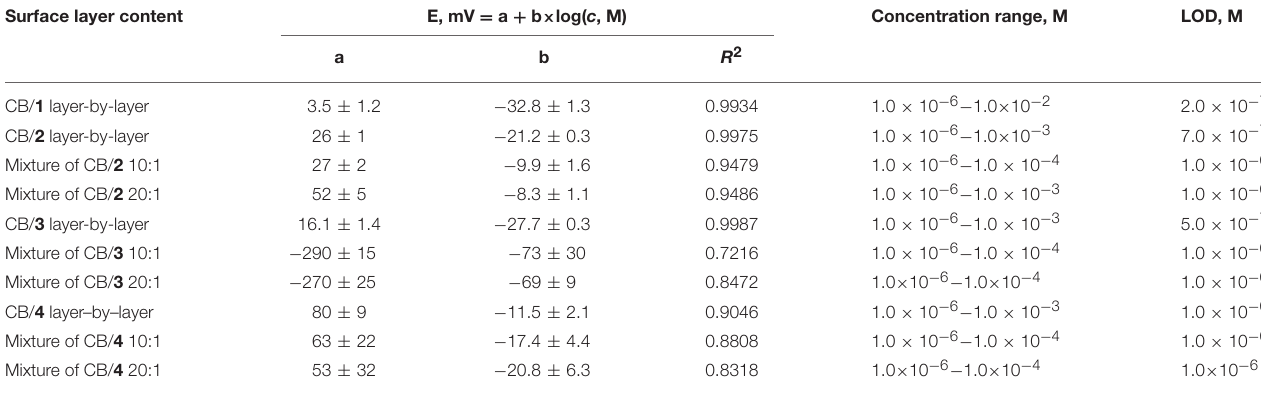
TABLE 1 | Analytical characteristics of hydrogen phosphate determination with solid-contact potentiometric sensor based on CB and IL 1 - 4 . Surface layer content